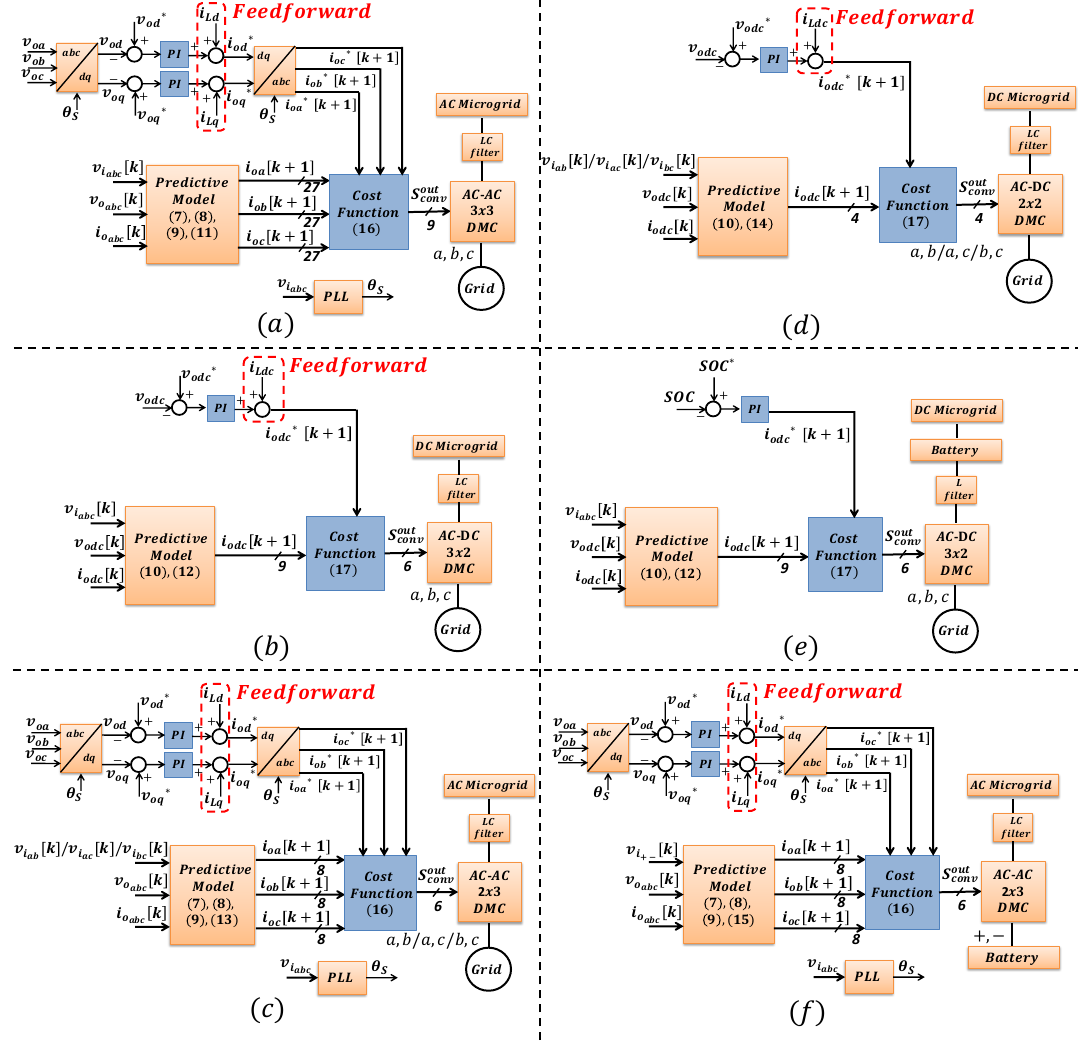
Figure 2. Control diagrams. ( a ) AC-AC 3 × 3, ( b ) AC-DC 3 × 2, ( c ) AC-AC 2 × 3, ( d ) AC-DC 2 × 2, ( e ) SOC control in hybrid DMC, and ( f ) hybrid DMC in islanded